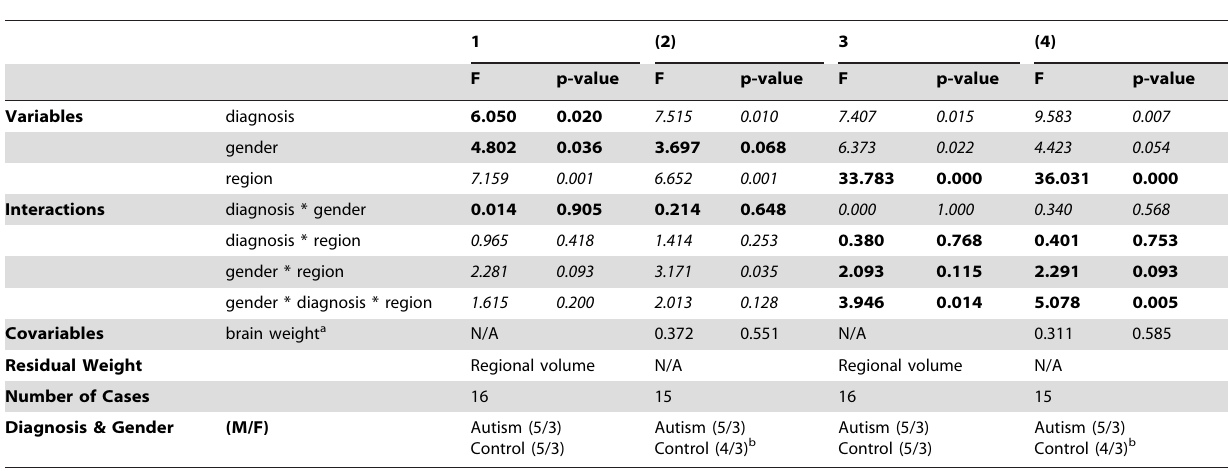
Table 2. Linear Mixed Models.